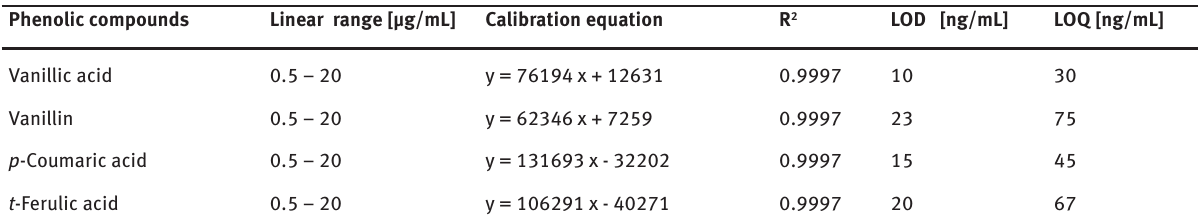
Table 2: Parameters of the HPLC analyses of four used phenolic compounds. Phenolic compounds Linear range